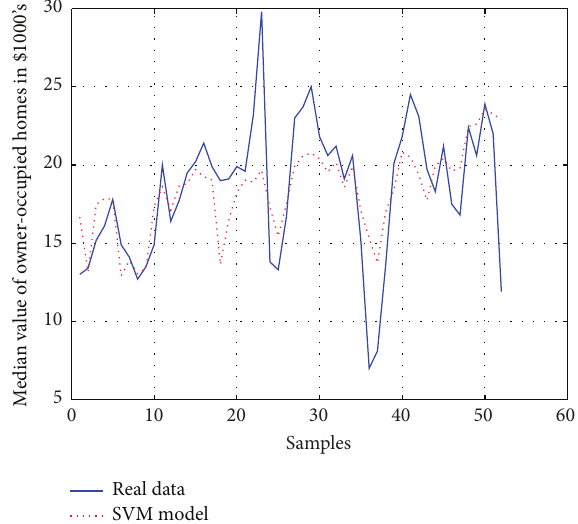
Figure 2: Housing value of the training data.